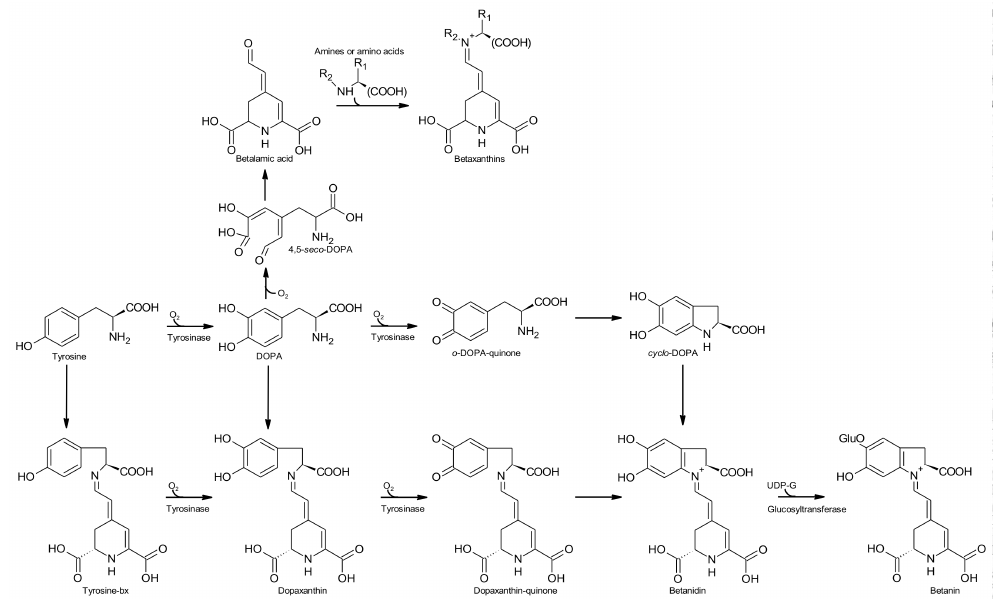
Figure 4. Simple scheme for the biosynthetic pathway of betalains (adapted from